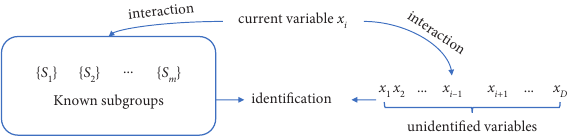
Figure 2: Hybrid-pool